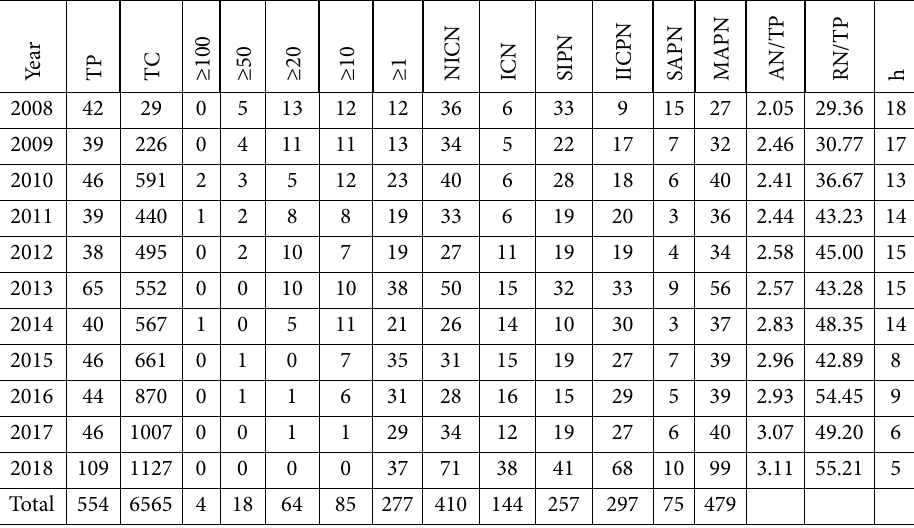
Table 1. General citation structure of the TEDE publications according to